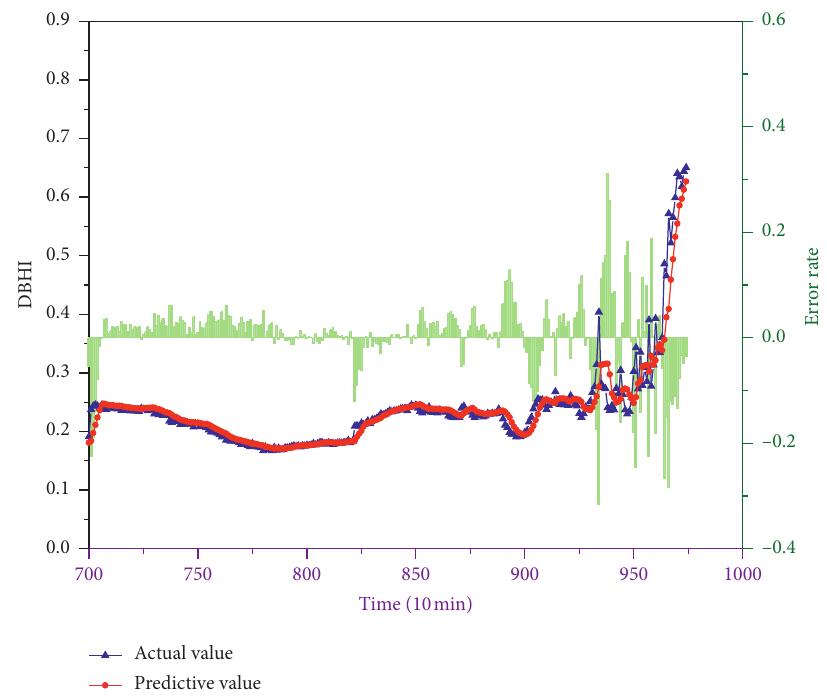
Figure 15: Prediction results and prediction error rates based on DBHI and LSTM.